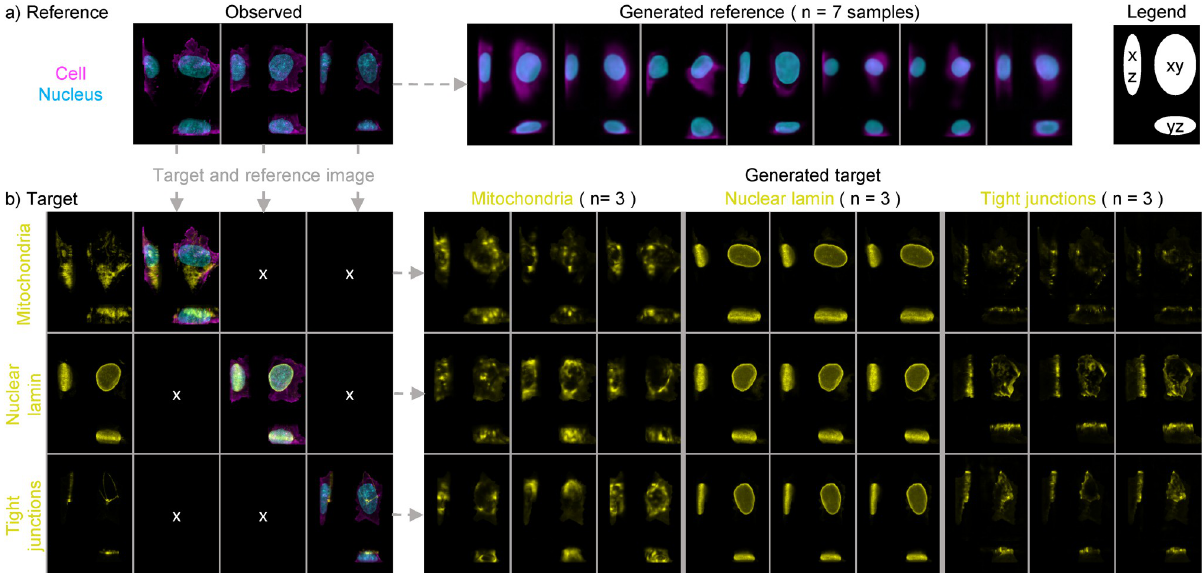
Fig 4. Generating cell images from the Statistical Cell model. a) Images can be generated from the probabilistic model of the cell membrane and the nucleus. On the left are three examples of actual cells. On the right are seven generated cells, sampled using independent random draws from the latent space. b) Cell and nuclear image data of actual cells can be used to generate a simulated image of a given structure even if that structure was not measured for that cell. On the left are three actual cells for which three different structures were imaged. From top to bottom: mitochondria, nuclear envelope and tight junctions. On the right are depictions of the generated structure channels for each of these cells and structures. Three examples of each structure in each cell are shown, each generated using independent random draws from the latent space. See S4 and S5 Figs for more examples.